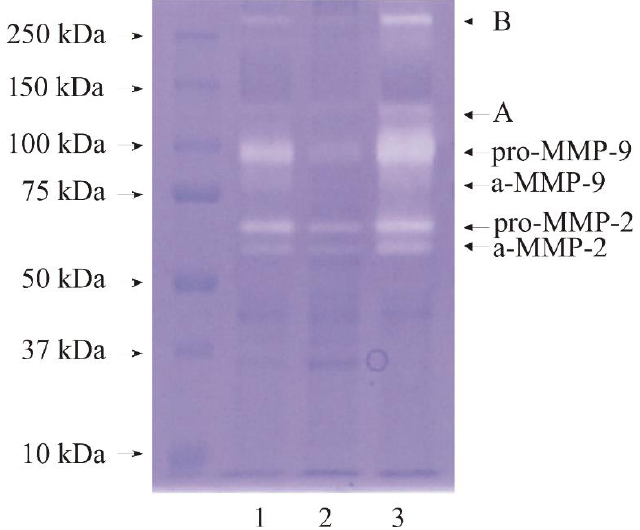
Figure 1. Zymogram shows the ability of gelatin degradation by proteins contained in the control tissue, low-, and high-grade bladder cancer samples. Twenty µg of protein in each sample was applied on the gel. Molecular mass standards were marked on the left of the zymogram. 1 — control sample; 2 — low-grade cancer sample; 3 — high-grade cancer sample.